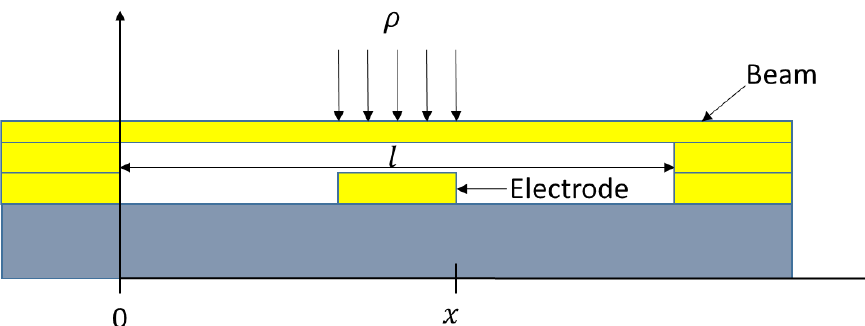
Figure 7. Electrode topology of the MEMS switch.